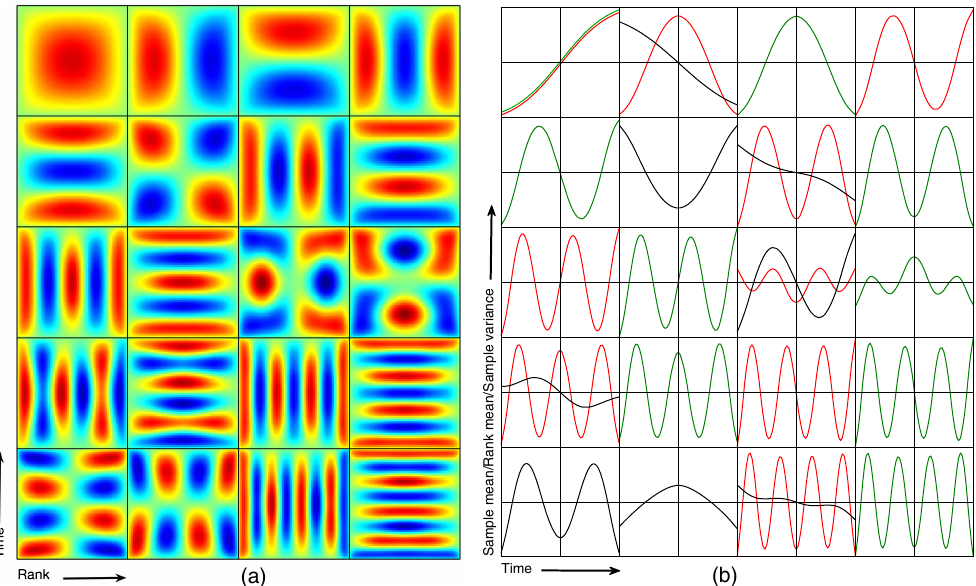
processes because of the reshuffling argument (see Sec. II).